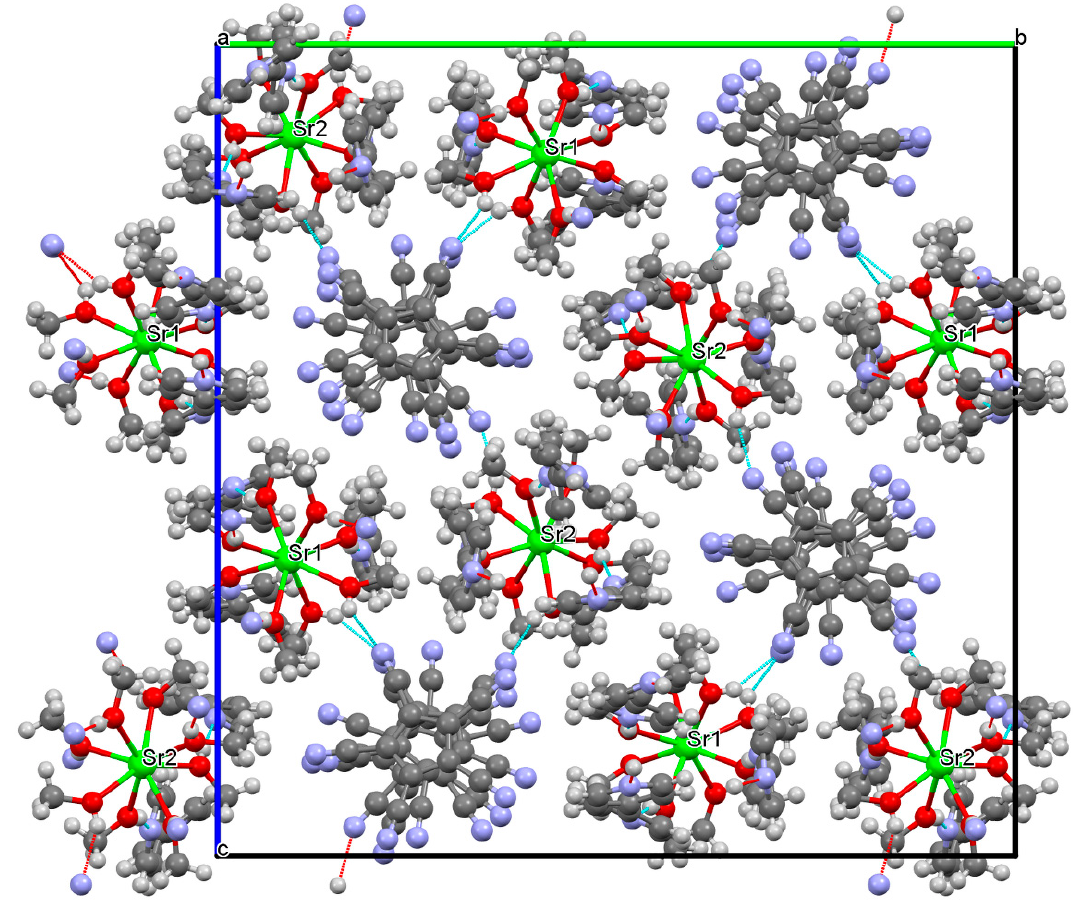
Figure 13. Complete packing diagram of compound 3 Figure 13 . Complete packing diagram of compound 3 . Figure 13 . Complete packing diagram of compound 3 . Table 2 . Important bond lengths [Å] and angles [°] of compounds 3 and 4 . Table 2 . Important bond lengths [Å] and angles [°] of compounds 3 and 4 .